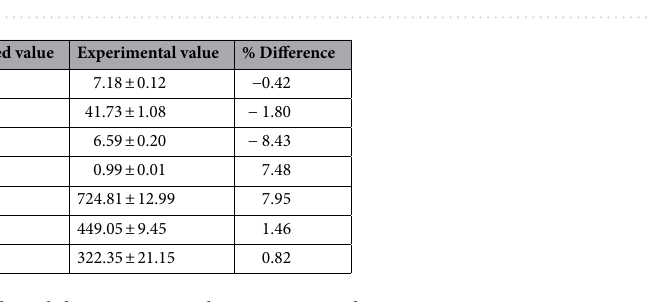
Figure 2. Overlay plot of response surface demonstrating the optimum formula for jasmine rice bran protein hydrolysates with flavourzyme : alcalase ratio (% w/w) and hydrolysis time (min).